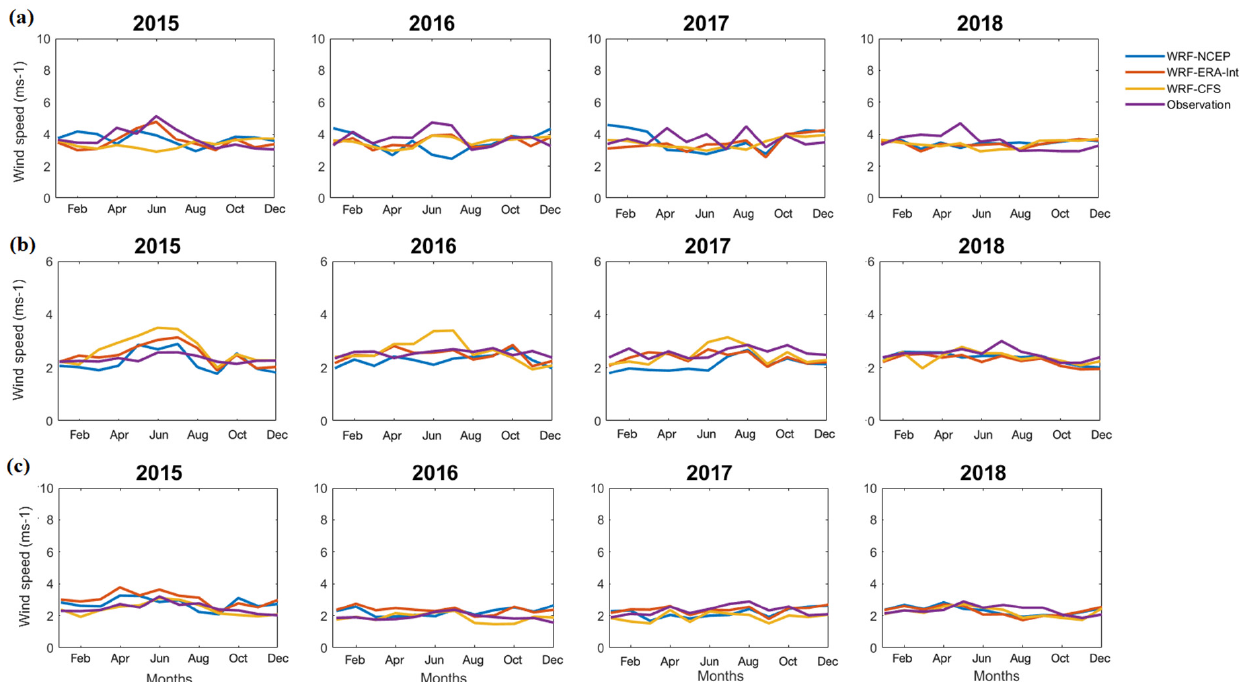
Figure A5. Monthly averaged wind speed in m s − 1 from the models and observations at the onshore locations ( a ) Shaoguan, ( b ) Nanping, and ( c ) Ganzhou.